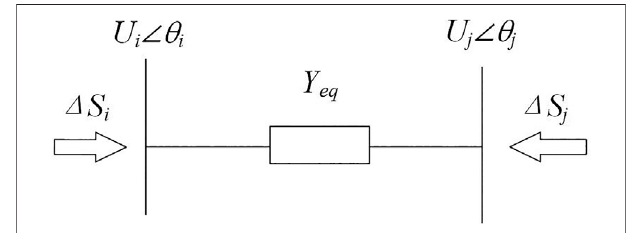
FIGURE 3 | The schematic diagram of equivalent injected power of phase-shifting